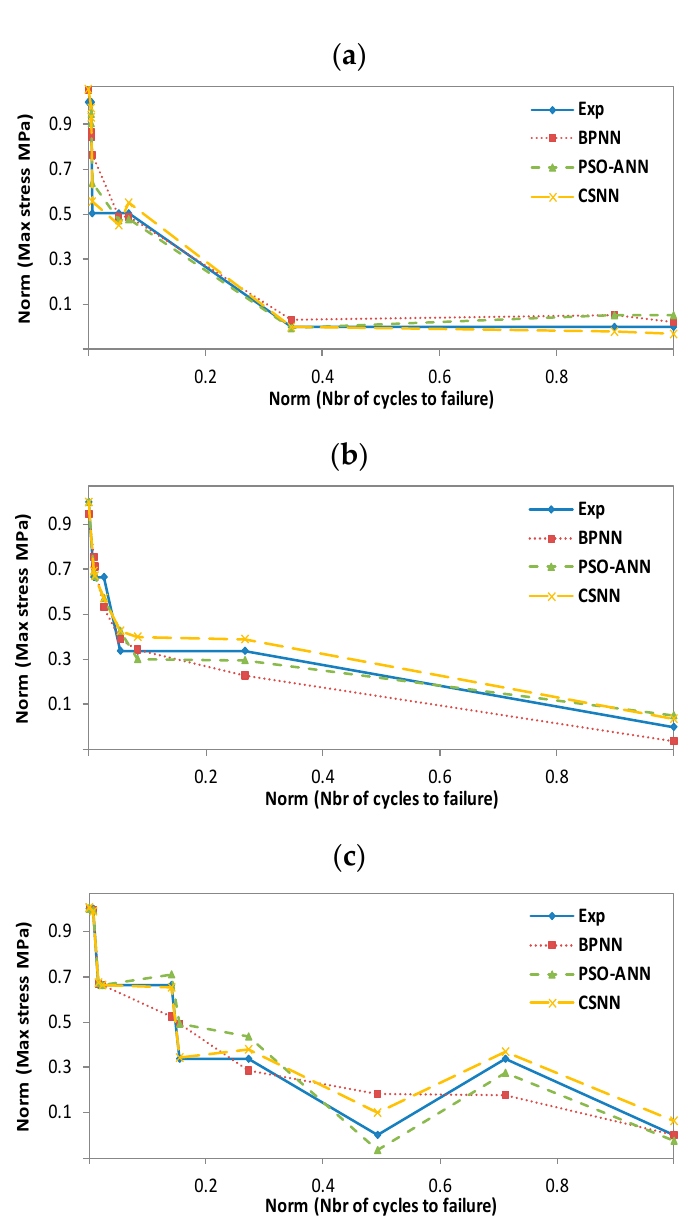
Figure 13. Experimental and predicted values of iso-polyester resin fatigue life (CoRezyn 75-AQ- 010). ( a ): T = 50 °C wet; ( b ): T = 20 °C dry; ( c ): T = 20 °C wet.